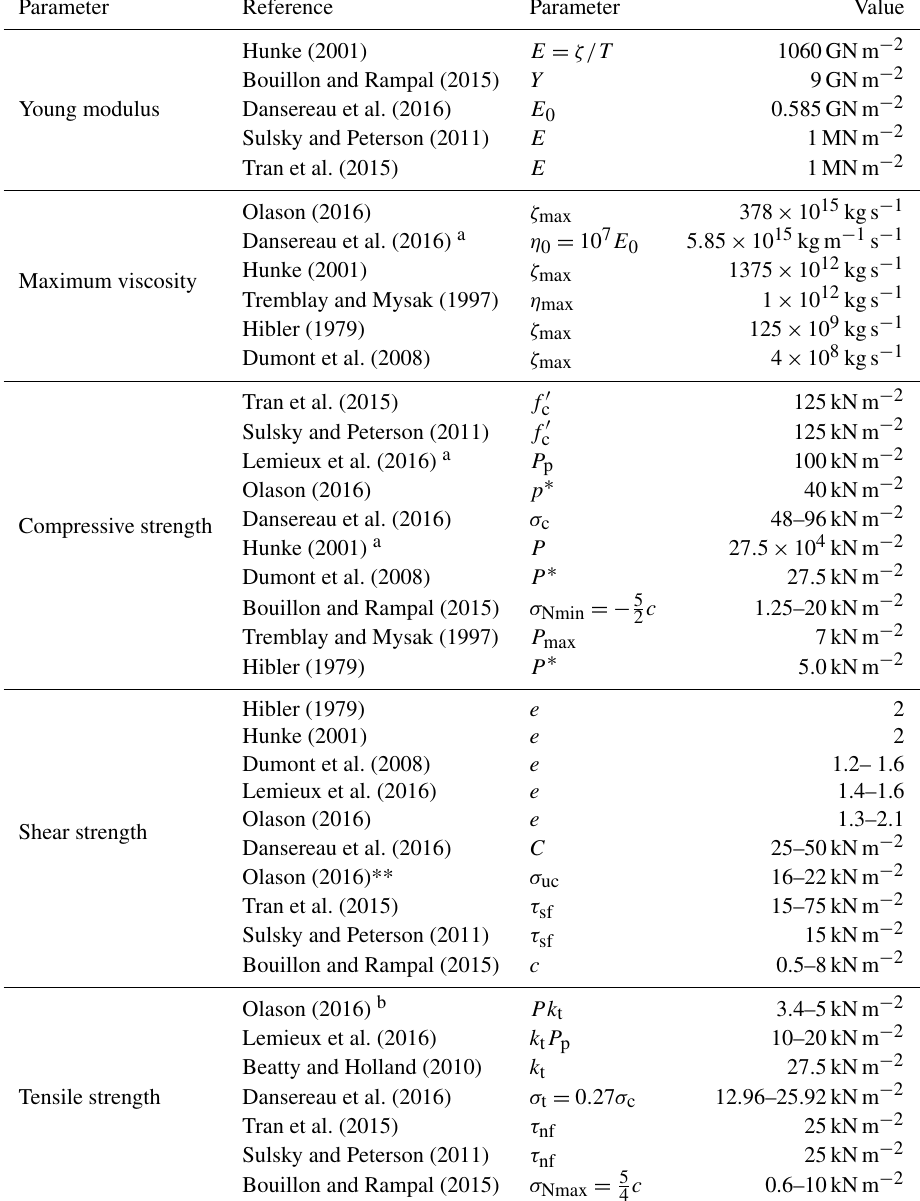
Table 3. Material properties used in sea ice models (VP, EVP and